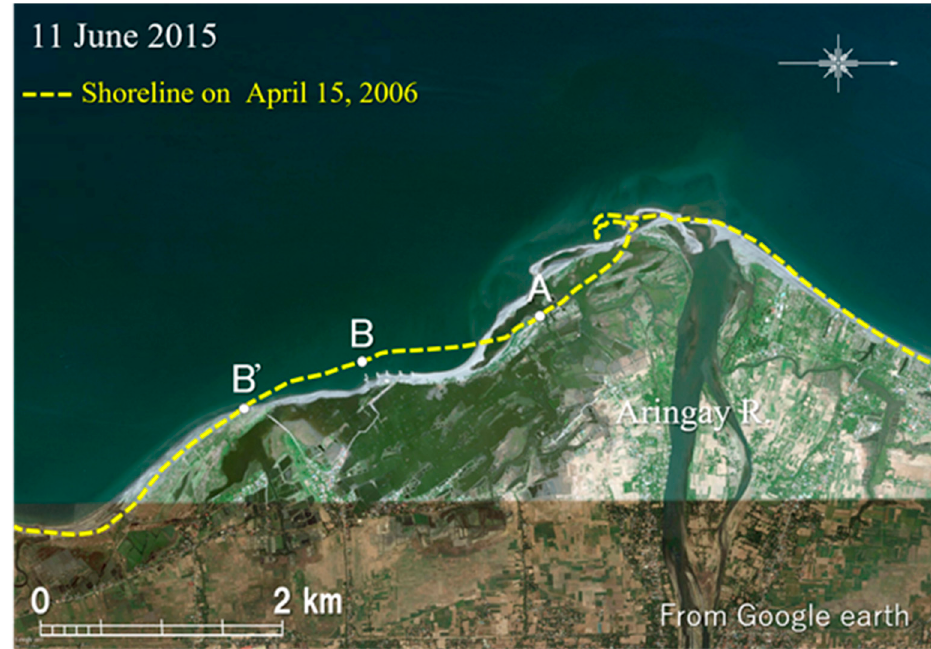
Figure 15. Satellite image of shoreline around Aringay River mouth (11 June 2015).